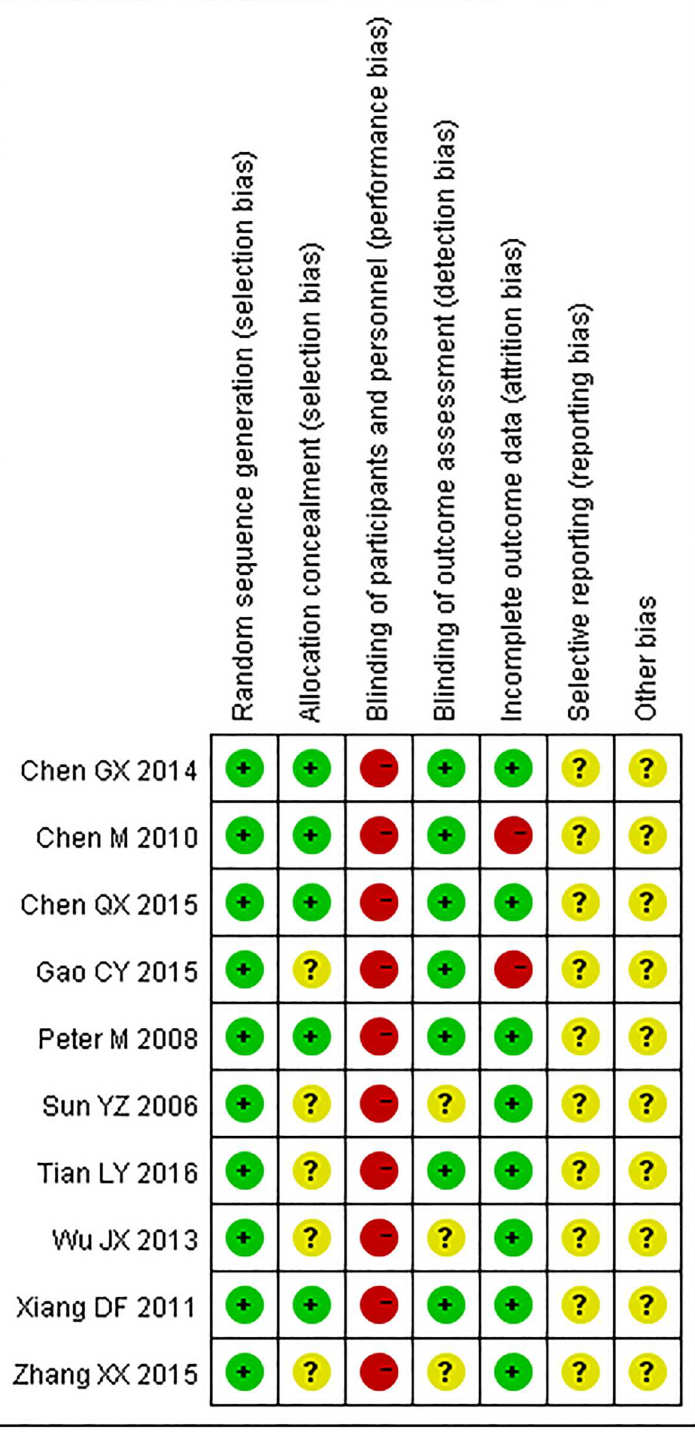
Fig 3. Risk of bias summary: review authors’ judgements about each risk of bias item in each included study.